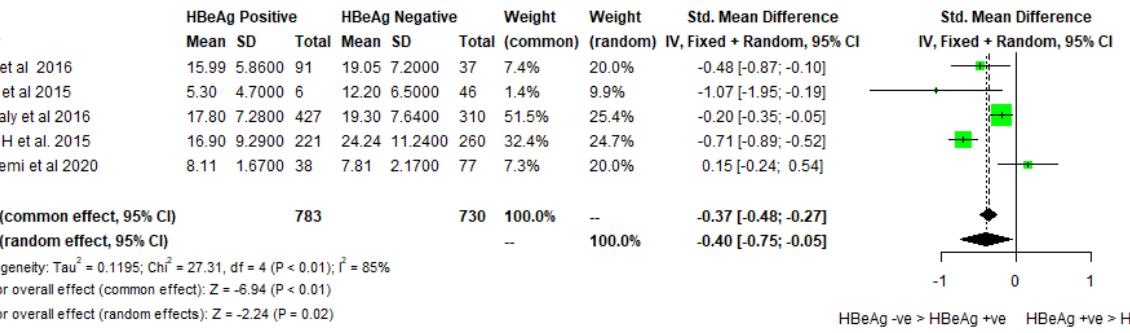
Figure 4. Forest plot of vitamin D levels between HBeAg ‐ positive and HBeAg ‐ negative Chronic Hepatitis B cases [22,27,29,36,43].